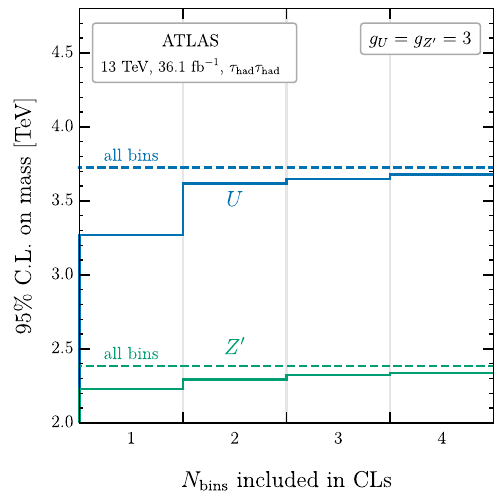
Fig. 5 Left: Distributions in m tot for the b –inclusive background and (blue) and a Z (cid:2) (green) when only the highest N bins are included in the T data from [44], a leptoquark (blue) and a Z (cid:2) (green) with masses and CLs, with couplings as shown. The dashed lines show the limit obtained when all bins are included couplings as shown. Right: The 95% C.L. on the mass of a leptoquark